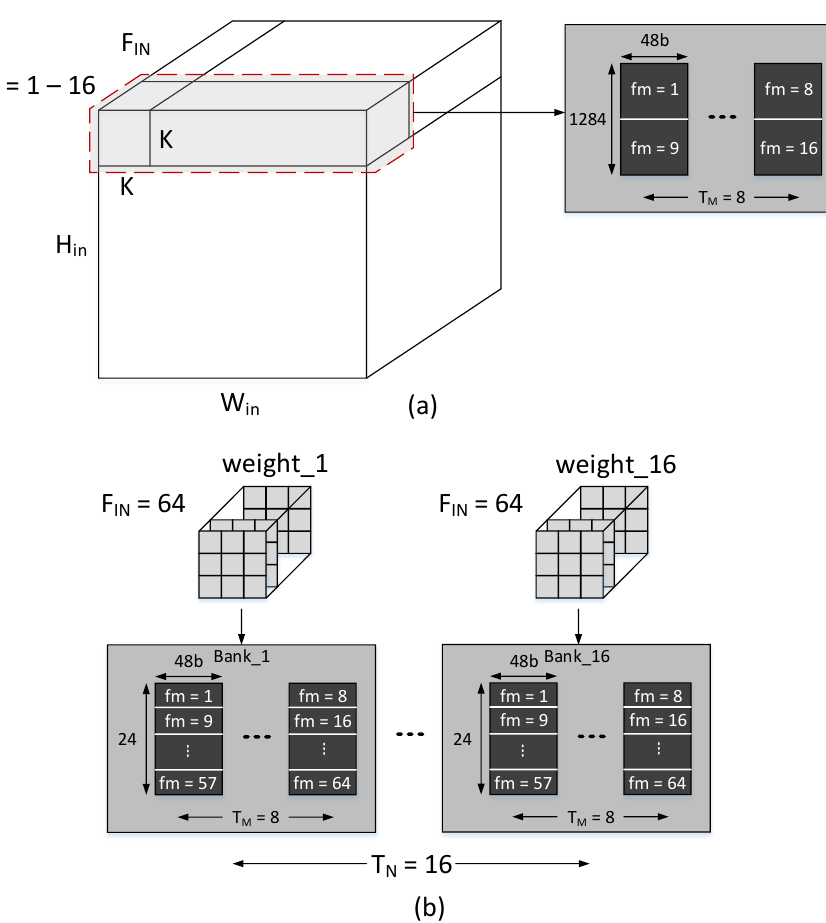
Figure 7. Conv1b layer example for data arrangement. ( a ) Input image data; ( b ) input weights